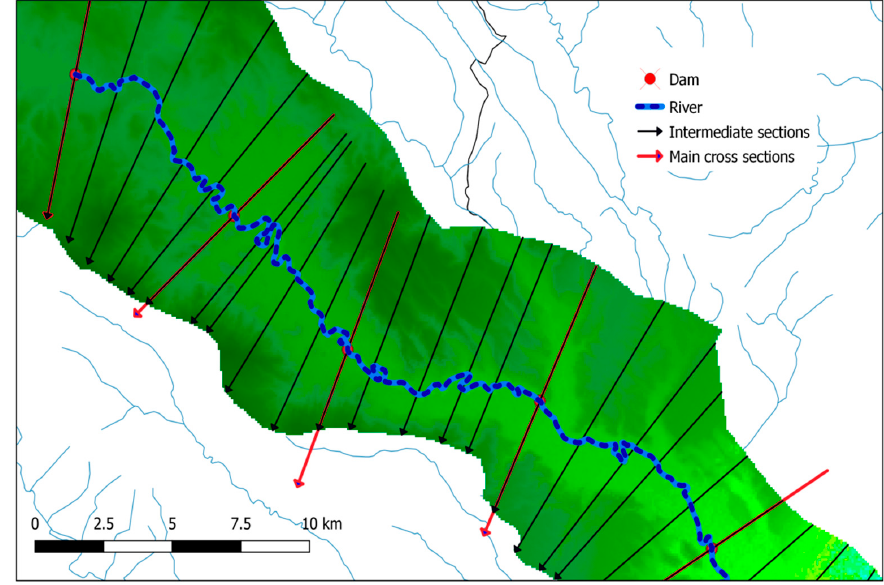
Figure 2. Example of the cross-sectional footprint delineation for an area of the valley downstream from the San Giuliano dam.